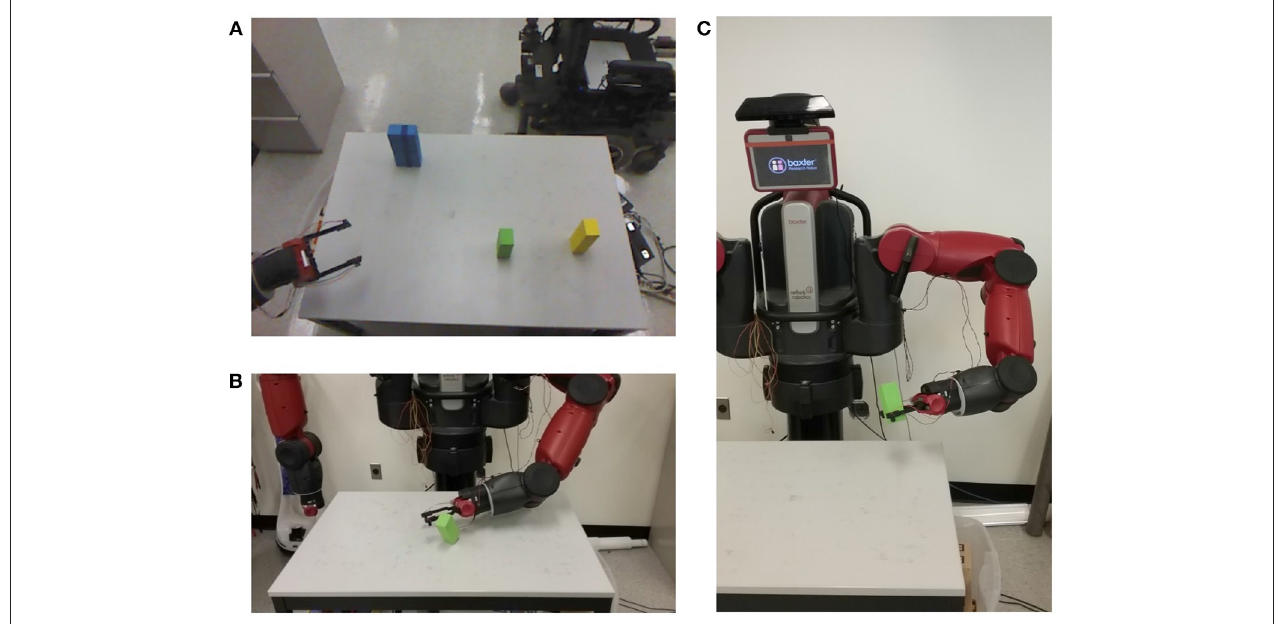
FIGURE 1 | Our experiments are done using a Baxter robot from Rethink Robotics. (A) The environment from the agent’s perspective, including simple block objects used in this work. (B) The unusual bump event is observed during random motions when the hand accidentally collides with an object and changes its state. The agent defines a reach action to make purposeful repetition of the bump event reliable. Actions are evaluated with a single foreground object present. (C) The grasp action allows the agent to control the motion of an object as it travels with the hand. The first grasps occur accidentally during reaching, and incorporation of additional preconditions and parameterizations makes intentional grasps increasingly